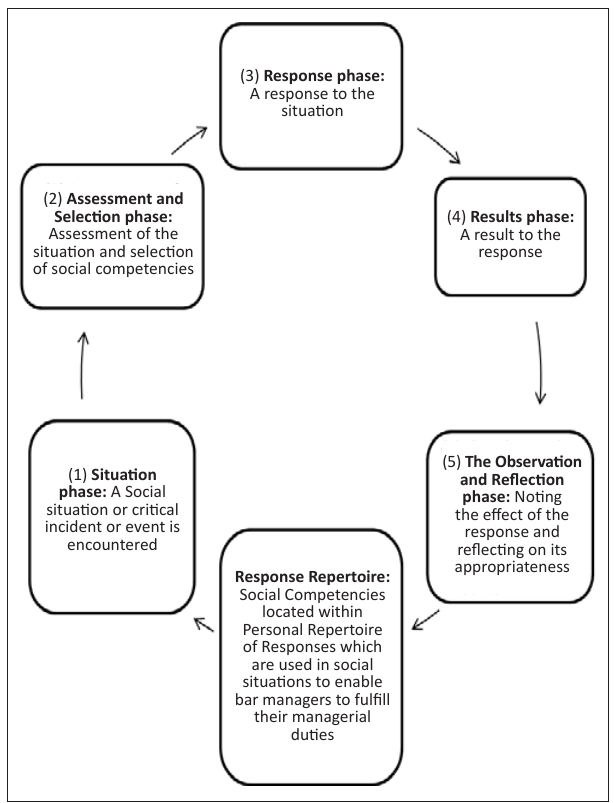
FIGURE 1: The Social Competency Cache Development